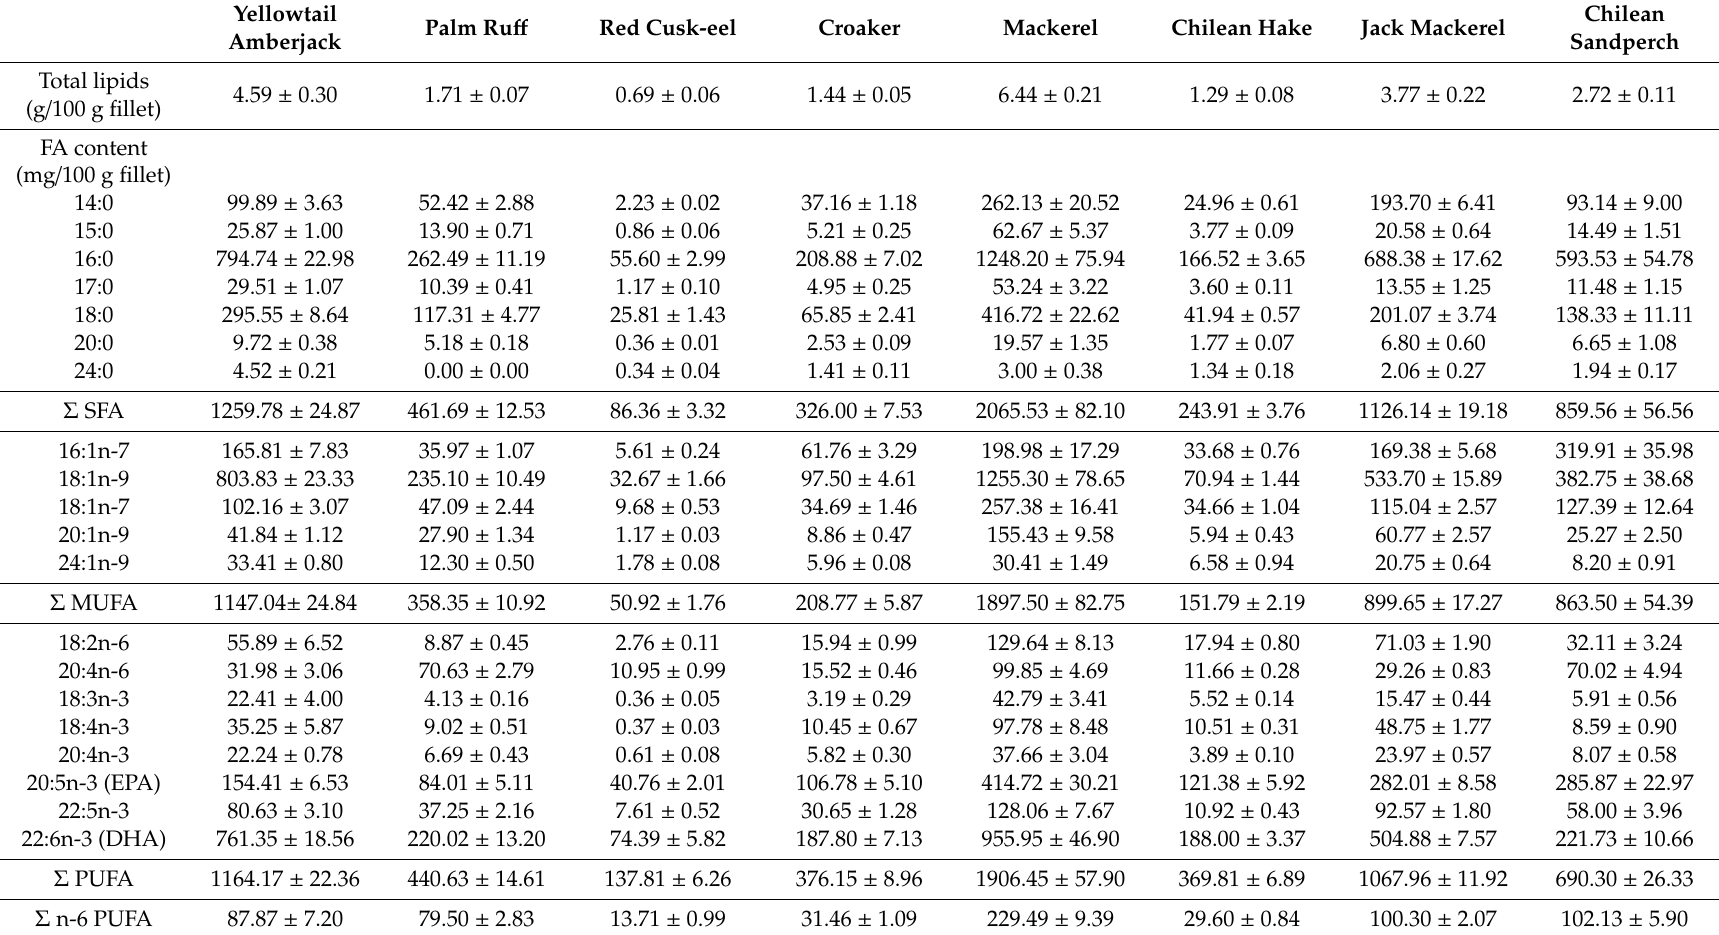
Table 2. Total extracted lipids (g / 100 g raw fillet) and amounts of each fatty acid (mg / 100 g raw fillet) in fish. Data are reported as mean ± standard deviation. Nutritional indexes (HH, PUFA / SFA and n-6 / n-3 ratios) and amounts of raw fish flesh needed to provide the minimal recommended daily amount of EPA + DHA (250 mg) for healthy adults are also